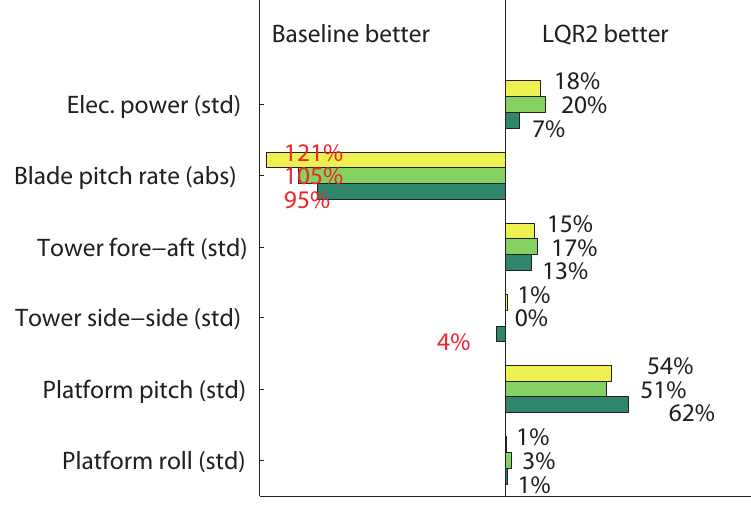
Figure 15. Perpendicular wind-wave forces: statistical analysis of relative controller performance, where yellow, light green and dark green represent peak wave periods of 2, 5 and 10 s,